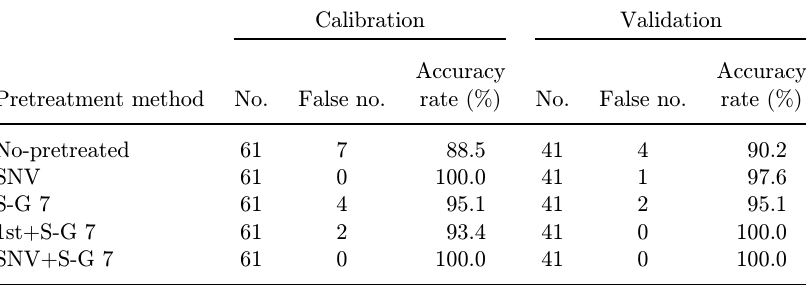
Table 2. Results of models based on di®erent spectral pretreatment methods.